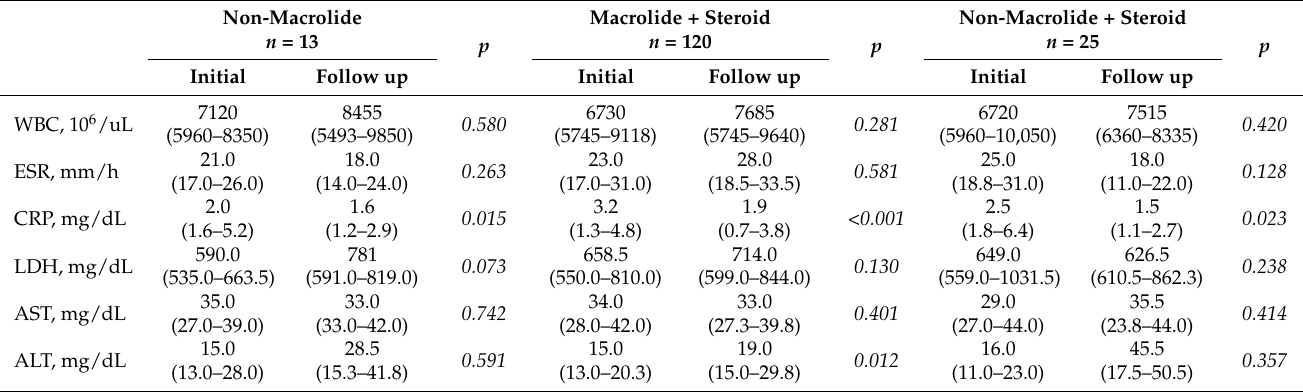
Table 2. Changes in laboratory parameters according to treatment